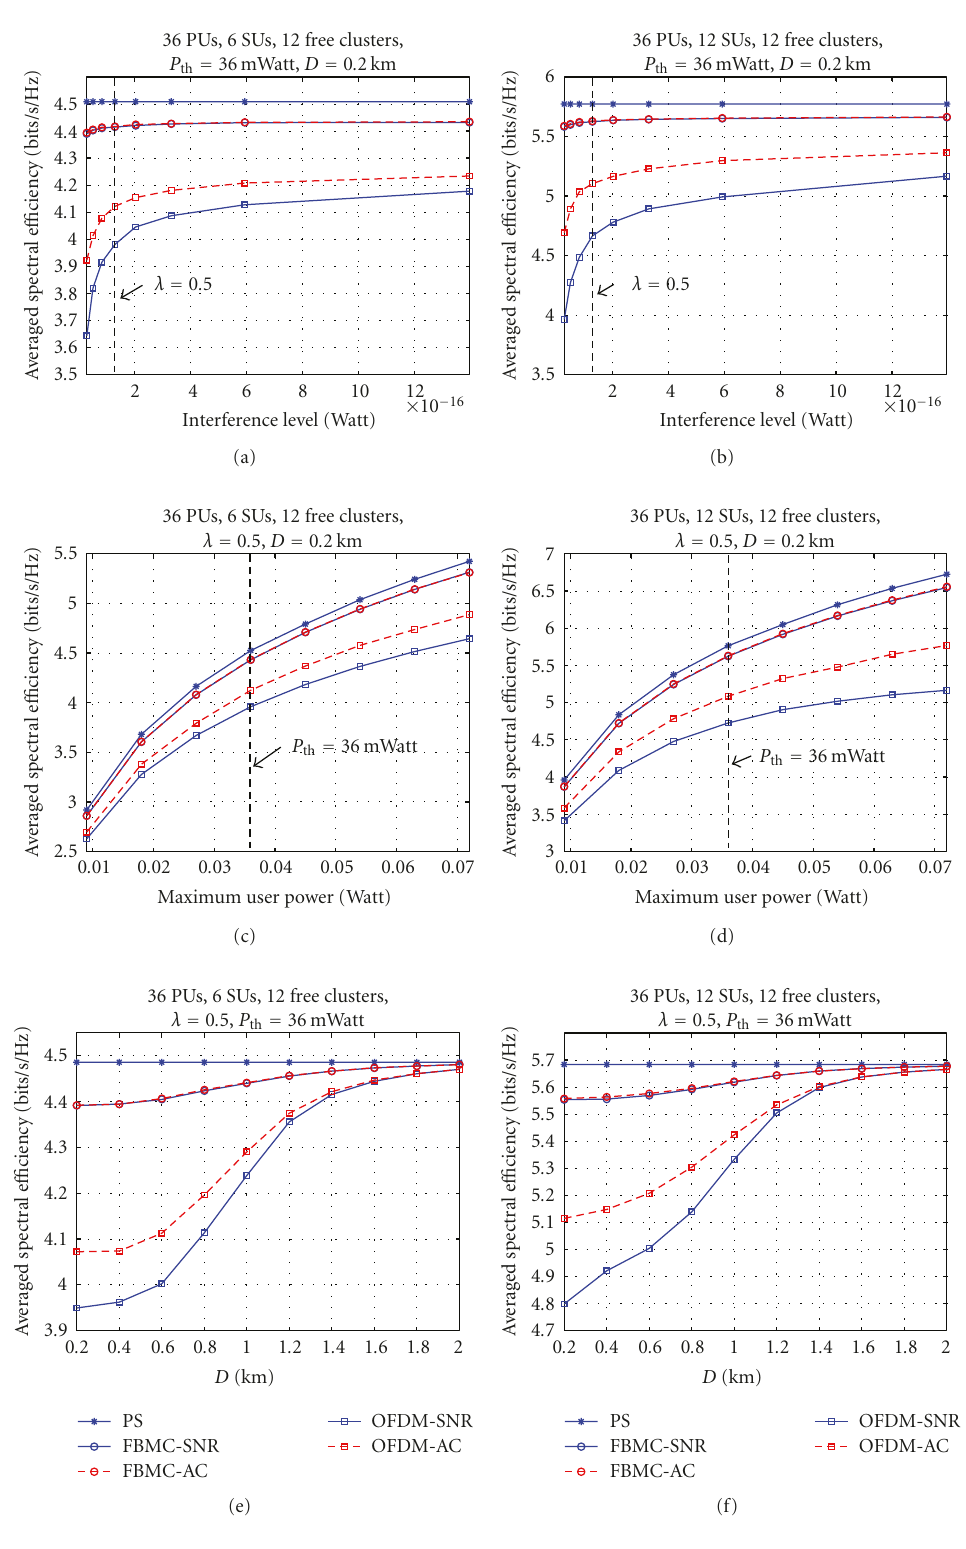
Figure 8: Experimental results of Multiuser resource allocation for multiple spectrum holes with F = 216: (a) Averaged spectral e ffi ciency versus interference level for 6 SUs. (b) Averaged spectral e ffi ciency versus interference level for 12 SUs. (c) Averaged spectral e ffi ciency versus maximum user power limit for 6 SUs. (d) Averaged spectral e ffi ciency versus maximum user power limit for 12 SUs. (e) Averaged spectral e ffi ciency versus distance between SBS and PBS for 6 SUs. (f) Averaged spectral e ffi ciency versus distance between SBS and PBS for 12